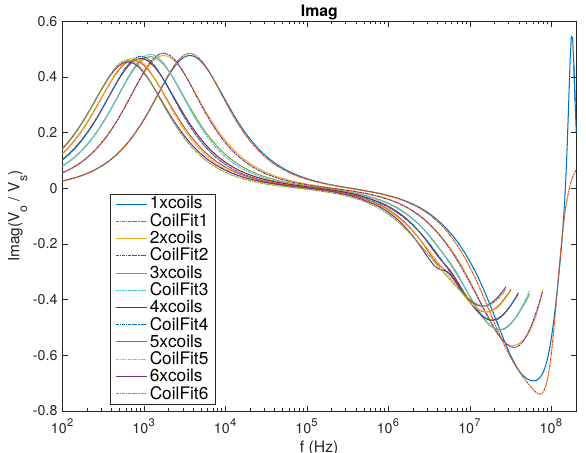
Figure 12. Fits (dash-dot lines) and measured data (continuous lines) of the imaginary part of the transfer function of the circuit configuration of Figure 8 and Equation (9) when the number of transformers connected in series varies from one to six. Table 1. Summary of the parameters extracted from the measured data, using the model of Equation (9). L p [ µ H] L PAR